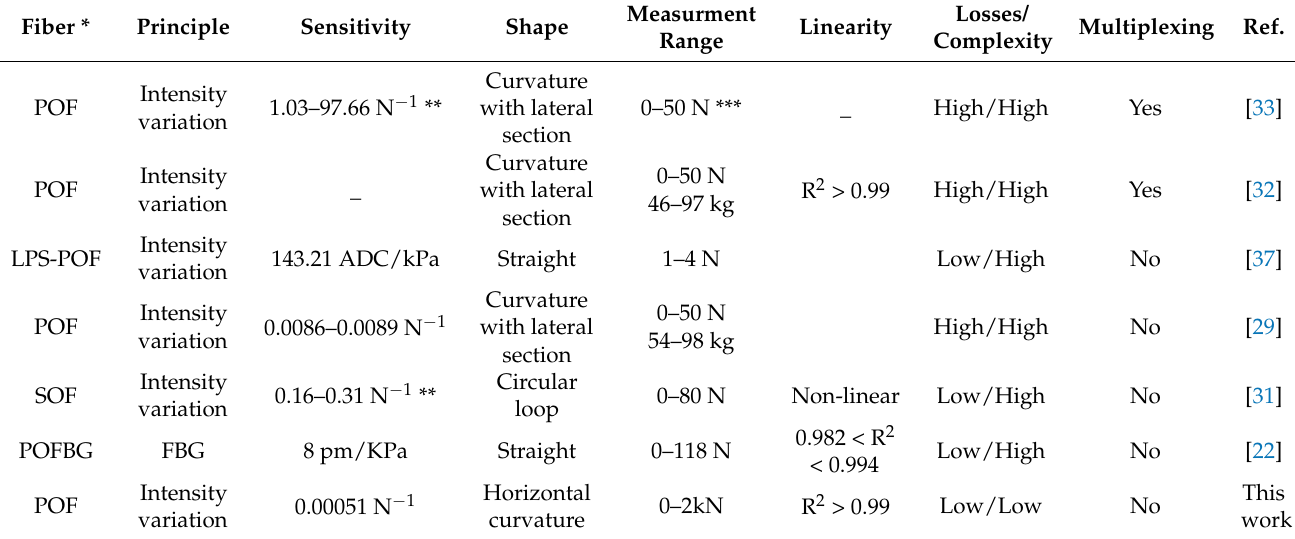
Table 3. Summary of optical fiber sensors’ characteristics.